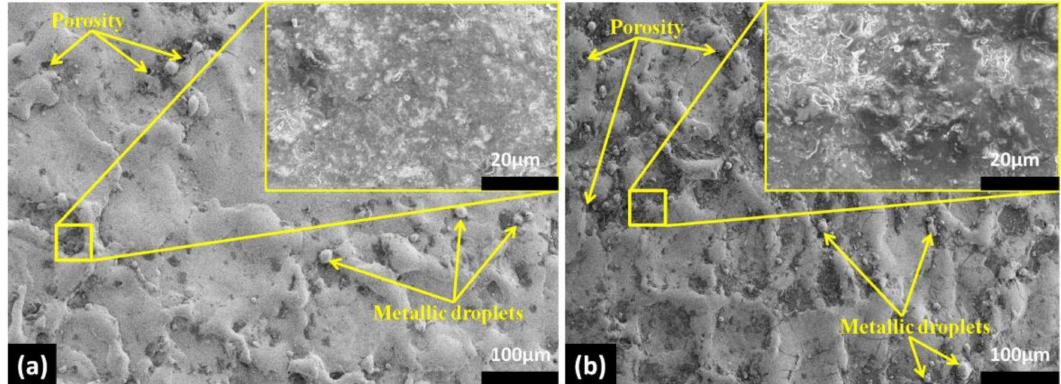
Figure 4. FE-SEM images illustrate surface roughness ( a ) Sample 8 (Ra = 1.4 µ s), and ( b ) Sample 9 (Ra = 1.21 µ